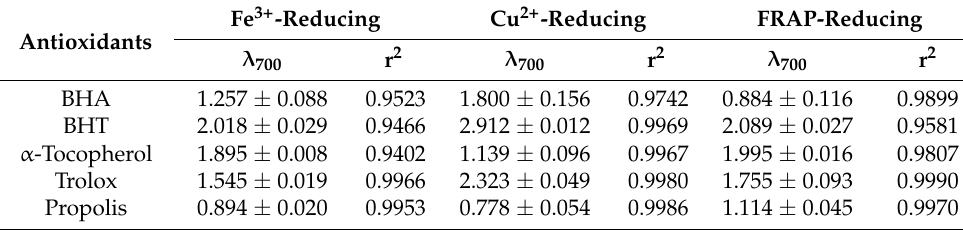
Table 3. The reducing abilities of propolis and standards a concentration of 30 µ g/mL.